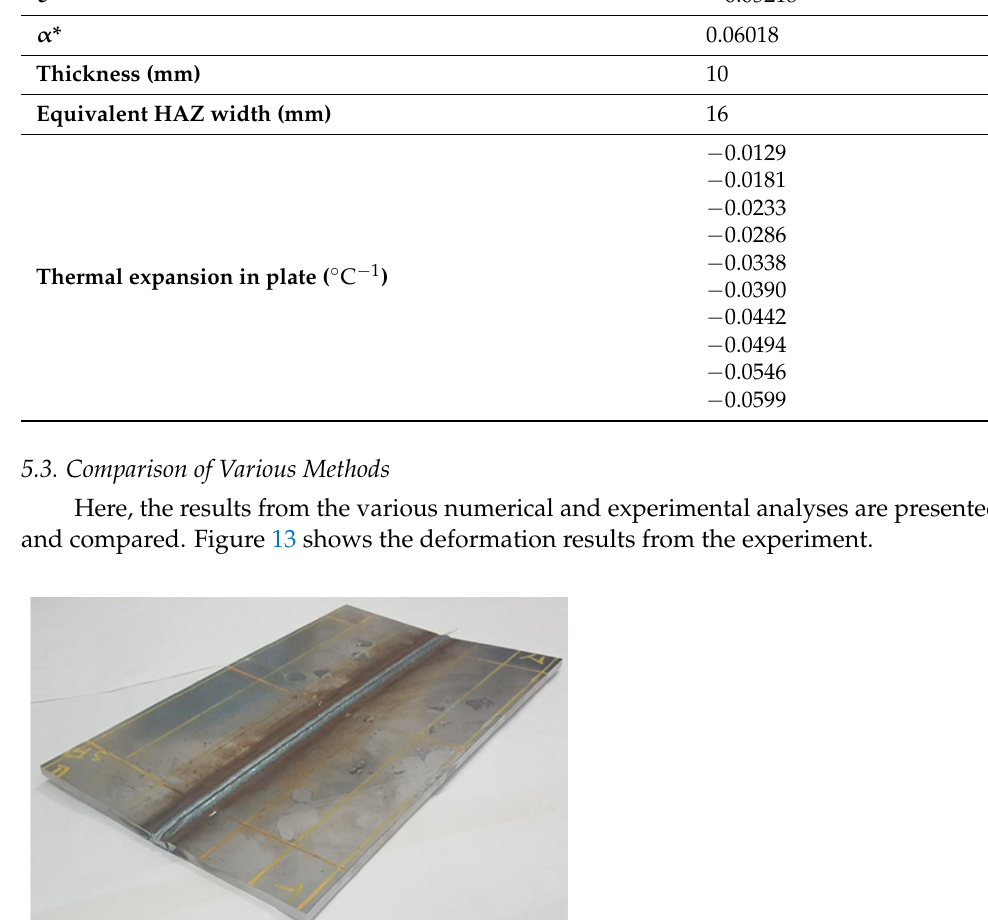
Table 6. Converted input variables for final distortion prediction.